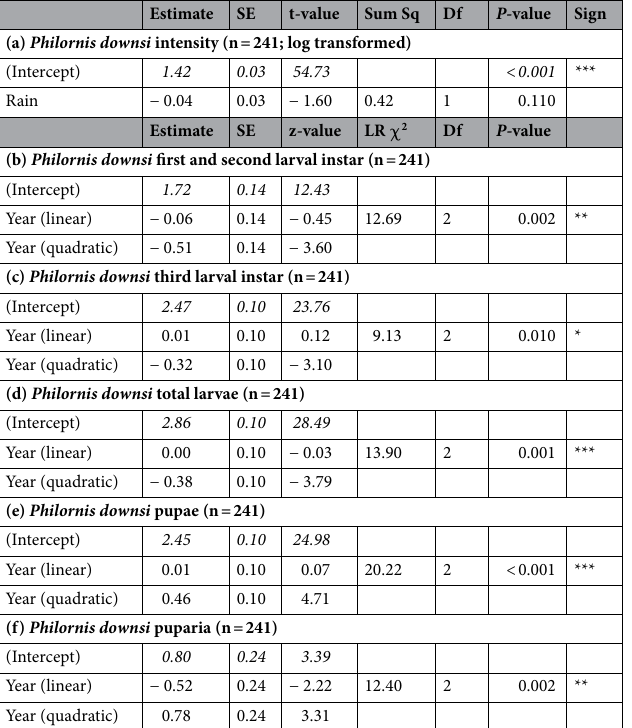
Table 2. Linear Models exploring the effects of rain and year on avian vampire fly ( Philornis downsi ) intensity and age class. (a) response variable P. downsi infection intensity, log transformed to achieve normality; and Generalized Linear Models (negative binomial distribution) of (b) first and second larval instar; (c) third larval instar; (d) total number of larvae; (e) total number of pupae; and (f) total number of puparia for the different life stages of P. downsi in relation to year and rainfall (fitted in a linear or quadratic relationship). We show the most parsimonious model after considering linear and quadratic relationships of year and rainfall and their interaction. Analysis of Deviance Table (Type III tests). Avian vampire flies collected from Darwin’s finch nests over 10 years across a 17-year period (2004–2020) on Floreana Island. Note all quantitative input variables were scaled and centred. A full intercept is only displayed for Linear Models and cannot be derived with the ANOVA function for Generalized linear models. Intercept presented in italics. Sign = significance levels: ‘***’ < 0.001; ‘**’ < 0.01; ‘*’ < 0.05; ‘.’ <